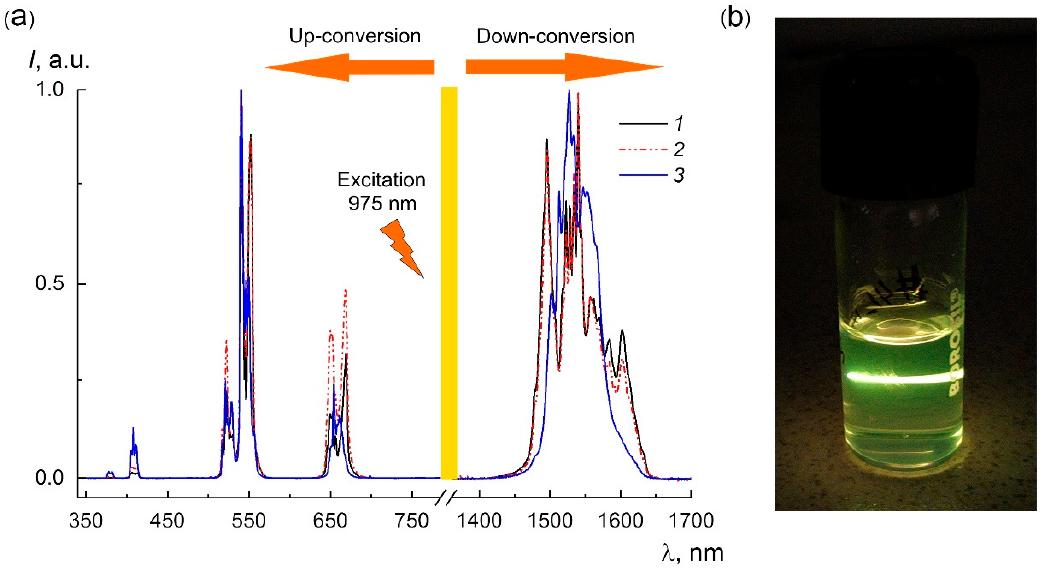
Figure 6. ( a ) The RT PL spectra of a bulk Ba(Y 0.964 Yb 0.030 Er 0.006 ) 2 F 8 crystal ( 1 ), Ba(Y 0.964 Yb 0.030 Er 0.006 ) 2 F 8 particles ( 2 ), and β -Na 1.5 (Y 1.17 Yb 0.3 Er 0.03 )F 6 ( 3 ) NPs upon excitation by λ = 975 nm radiation; ( b ) the appearance of a Ba(Y 0.964 Yb 0.030 Er 0.006 ) 2 F 8 colloid, performing intense green luminescence upon IR excitation ( λ = 975 nm). The luminescence spectra are normalized relative to the wavelength corresponding to the maximum radiation intensity in the visible (540 nm) and IR ranges (1535 nm).